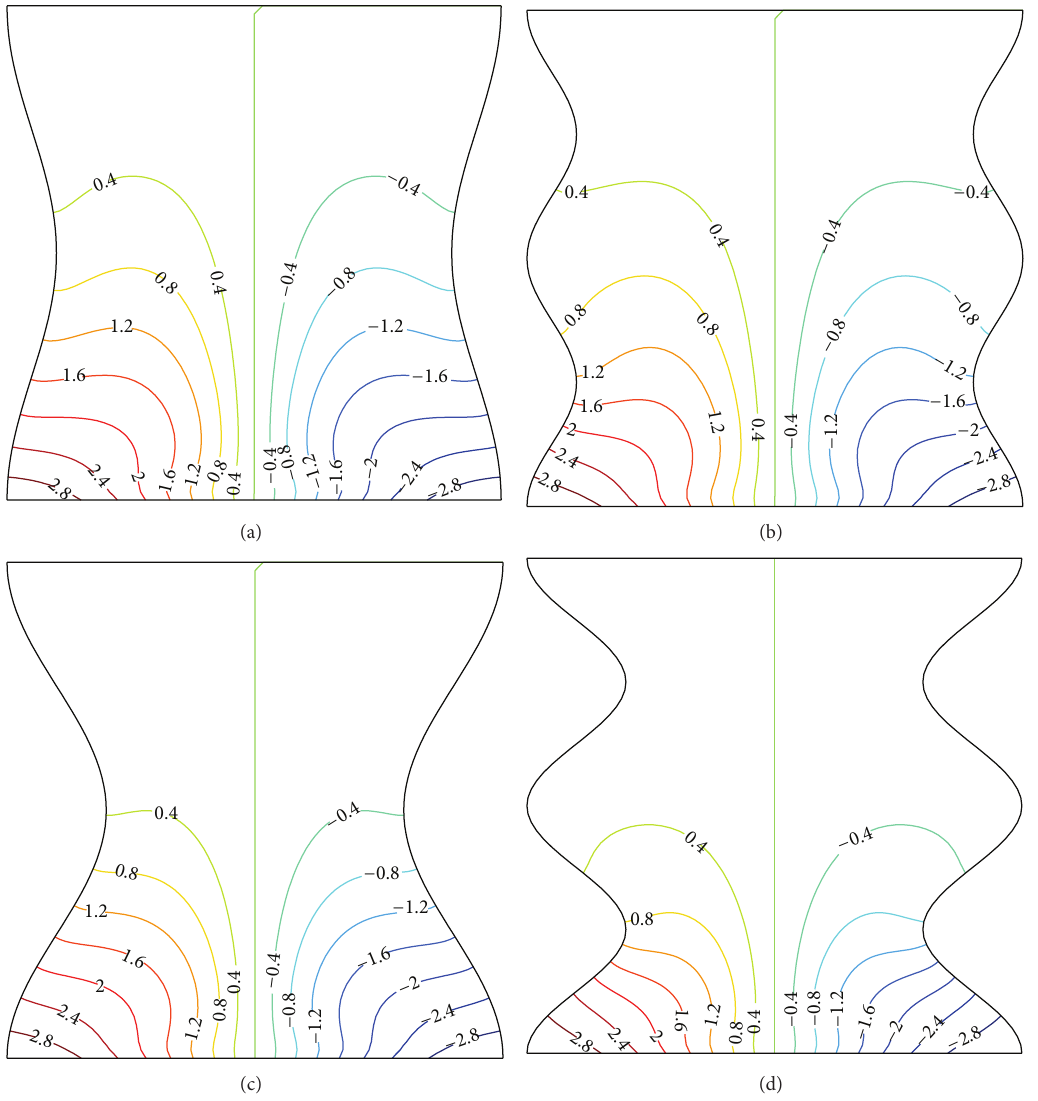
Figure 4: Heatlines ( Π ) for (a) 𝑛 = 1 , 𝜆 = 0.05 , (b) 𝑛 = 2 , 𝜆 = 0.05 , (c) 𝑛 = 1 , 𝜆 = 0.1 and (d) 𝑛 = 2 , 𝜆 = 0.1 .